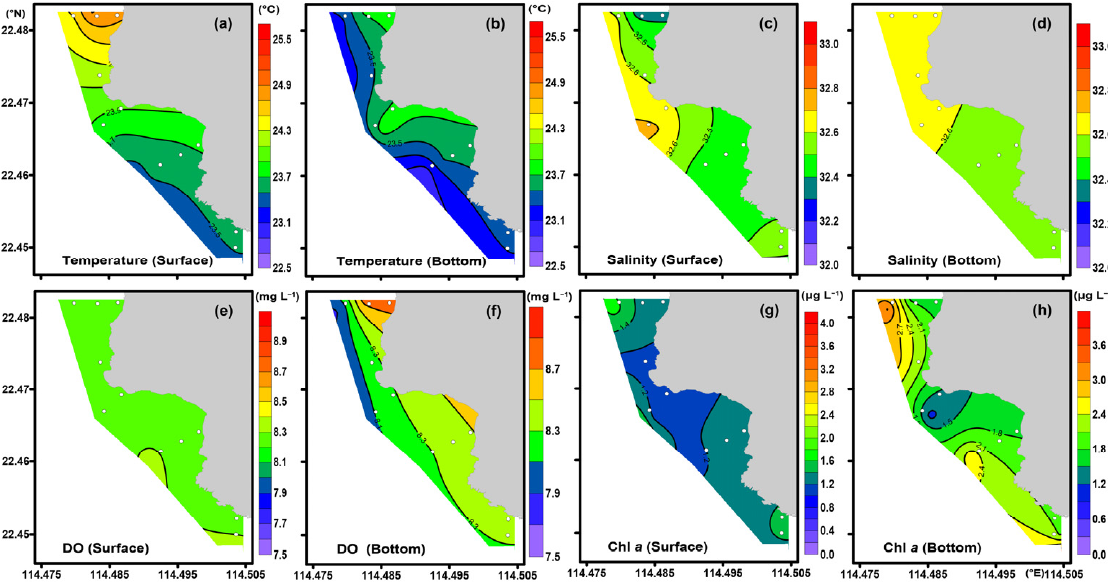
Figure A3. Distribution characteristics of temperature ( a , b ), salinity ( c , d ), DO ( e , f ) and Chl a ( g , h ), in the surface and bottom water of Dalu Bay (Area Ⅱ ).